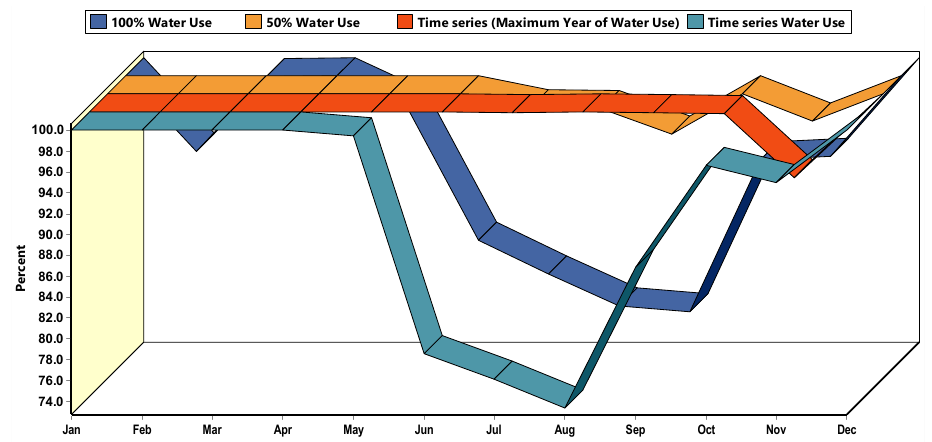
Figure 18. Average monthly flow requirement coverage (% of flow requirement) in Chester weir for the period of 2021–2039.